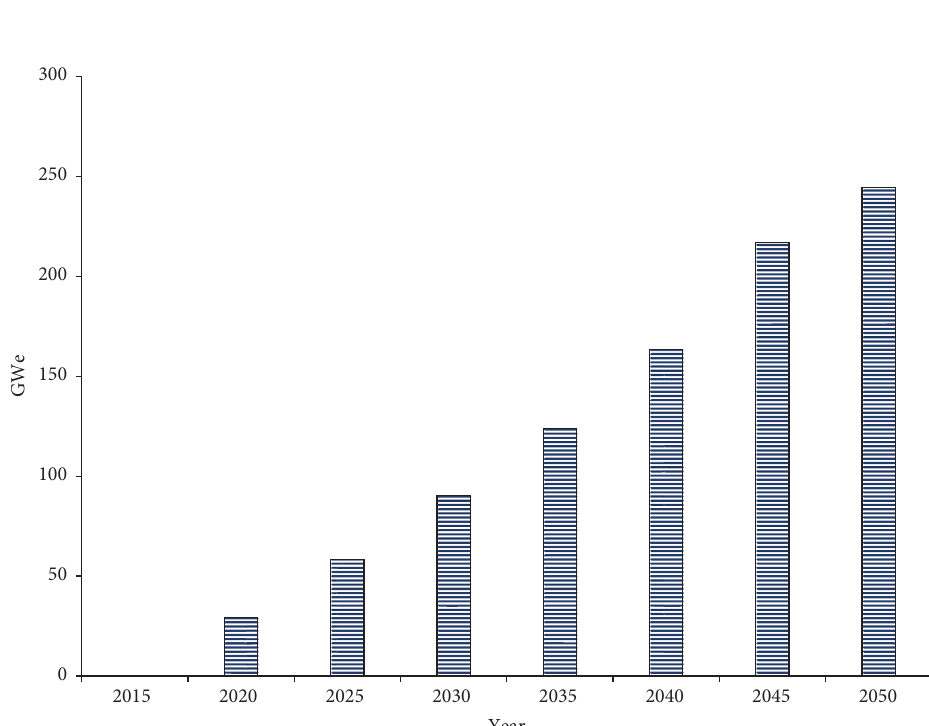
Figure 6: Increments from Scenario II compared to the calculated capacities from Scenario I.